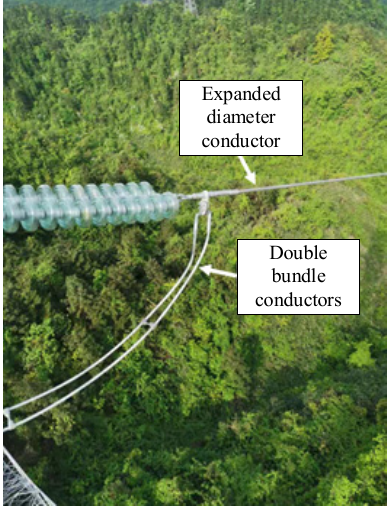
Figure 17. Application of DEC to replace double-bundled conductors.